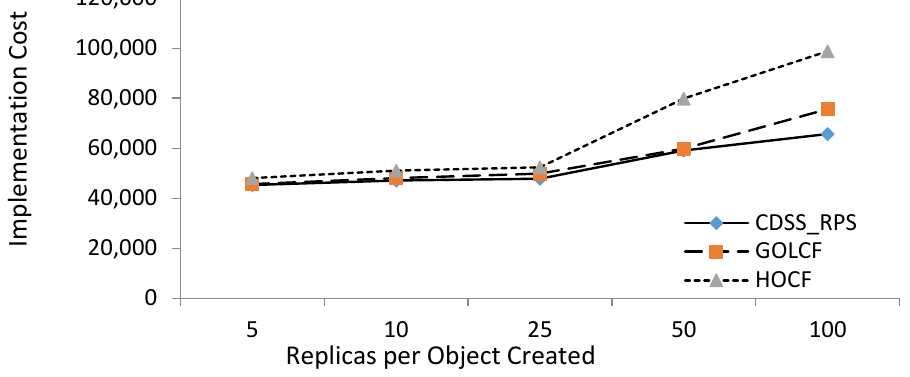
Figure 5. Schedule implementation cost w.r.t. CDSS_RPS, greedy object lowest cost first (GOLC) and highest opportunity cost first (HOCF).